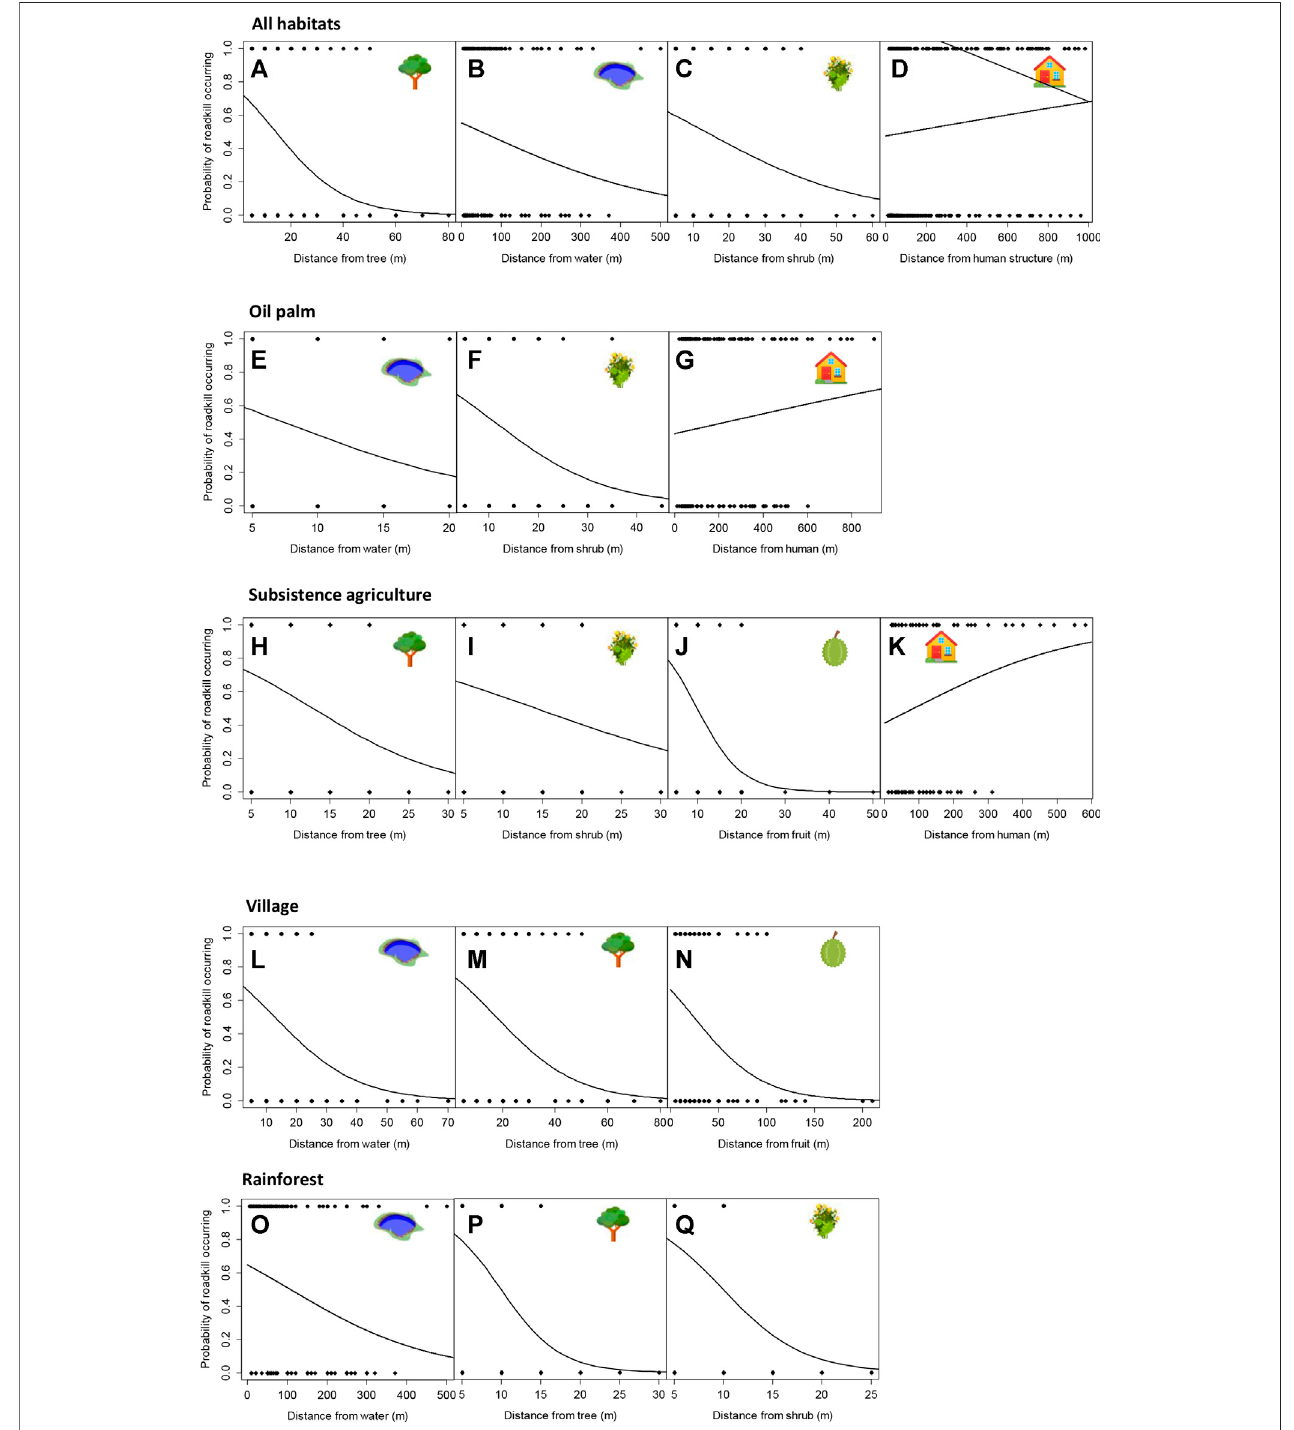
FIGURE2| Probabilitythataroadkillwilloccurwithincreasingdistancefromthenearestwaterbody (A) ,tree (B) ,shrub( C) orhumandwelling (D) inallhabitatsand for all taxa combined; water body (E) , shrub (F) or human dwelling (G) in oil palm habitat; tree (H) , shrub (I) , fruit tree (J) or human dwelling (K) in subsistence agriculture habitat; water body (L) , tree (M) or fruit tree (N) in village habitat; and water body (O) , tree (P) or shrub (Q) in rainforest habitat.